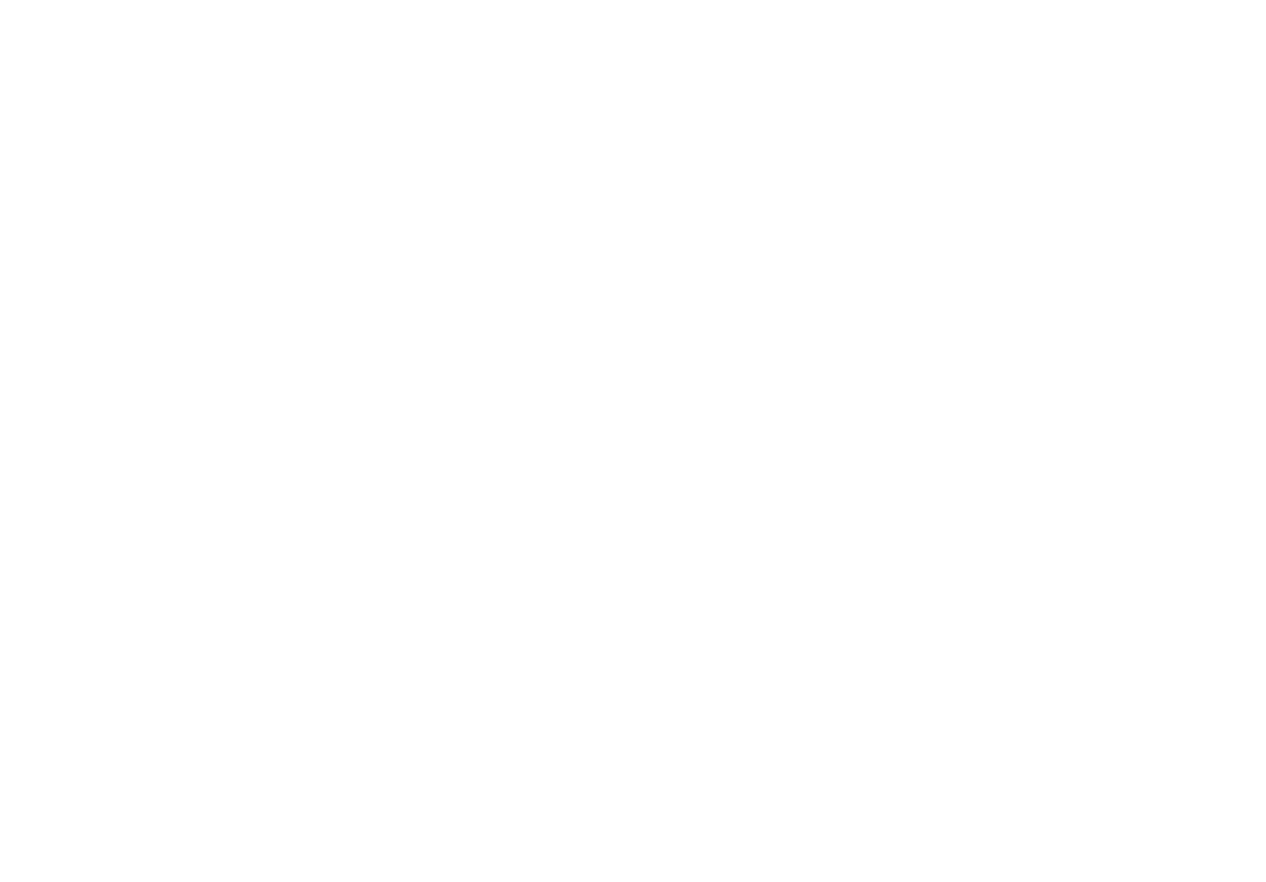
FIGUREA1 | Modeling heritability in twin studies. This diagram shows how twin studies can model variance components, based on the path diagram proposed by Neale and Cardon (1992).The lines adjoining variance components indicate the degree of correlation ( r ), shown for both monozygotic (MZ) and dizygotic (DZ) twins. Additive genetic variance (A) is 100% correlated for MZ twin pairs and 50% correlated for DZ twin pairs.